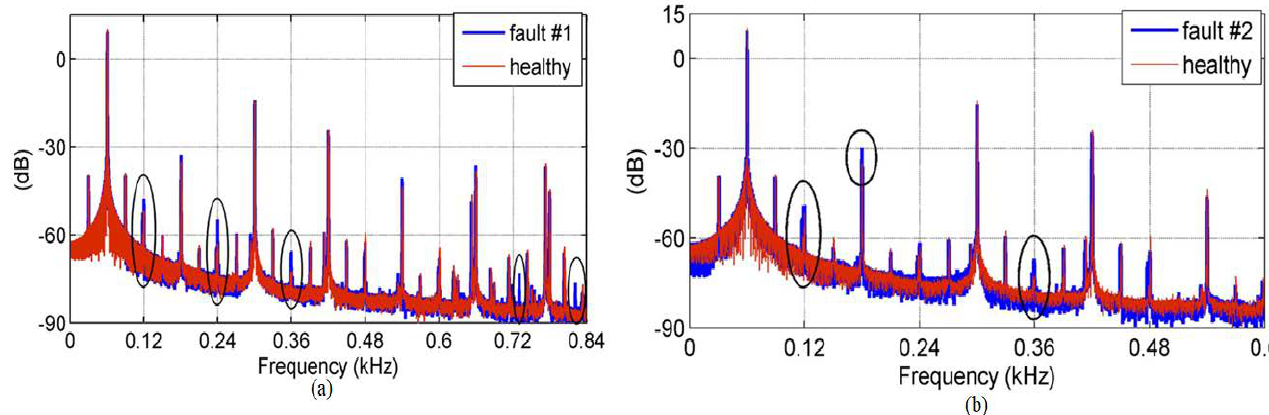
Figure 25. Comparison of the stator current spectrum for ( a ) healthy bearing and ( b ) faulty bearing, where significant change in the amplitude of certain harmonics is highlighted by circles [71].